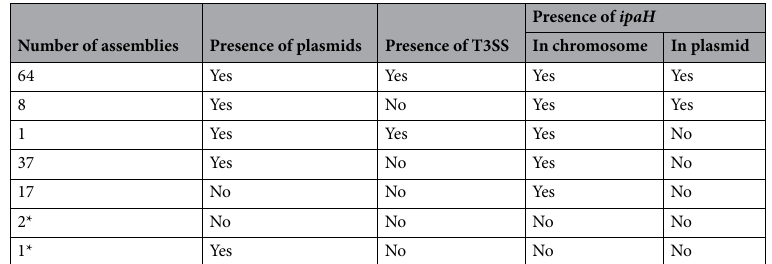
Table 1. Statistics of Shigella assemblies. *These strains were re-classified as non-invasive E. coli.